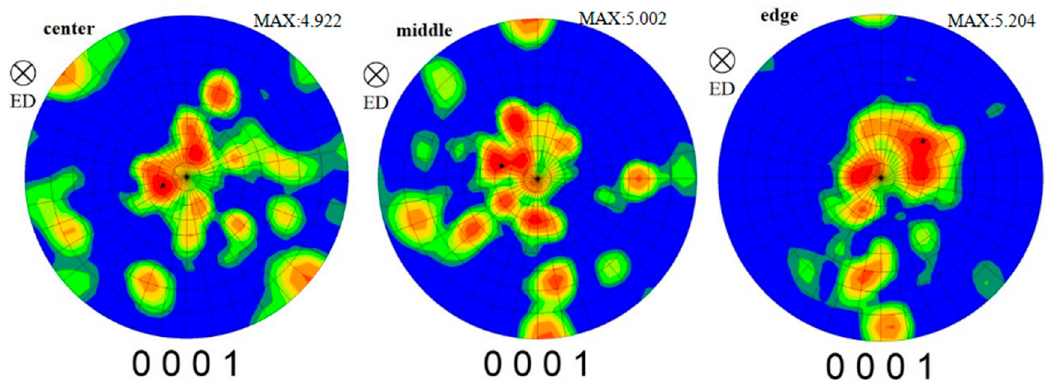
Figure 15. The (0001) pole figure of different parts under a strain rate of 0.1 s − 1 .